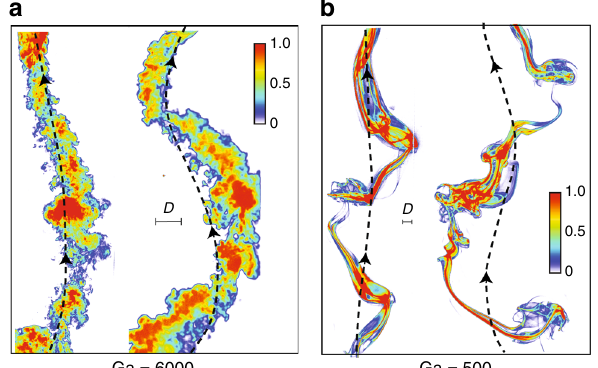
Fig. 4 Free-rise experiments of buoyant spheres. a Trajectories and wakes of high (left) and low (right) MoI spheres at Ga ≈ 6000. b Trajectories and wakes of high (left) and low (right) MoI spheres at Ga ≈ 500. In a , b , the wakes were visualized by releasing a fl uorescent dye. False coloring was adopted based on the intensity of the dye in the wake. Note that the diameter scale ‘ D ’ is shown in each case. Reducing the MoI or allowing rotation at fi xed Γ triggers an increase in the oscillation amplitude along with a change in the wake pattern. Supplementary Movies 4 and 5 correspond to the cases shown in a , b ,